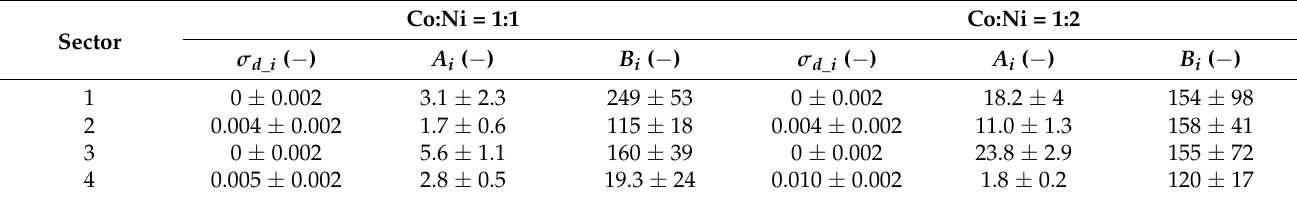
Table 1. Values of A i , B i , and σ d_i of Equations (8) and (9) for the sectors of the hillocks in 1:1 and 1:2 solutions.